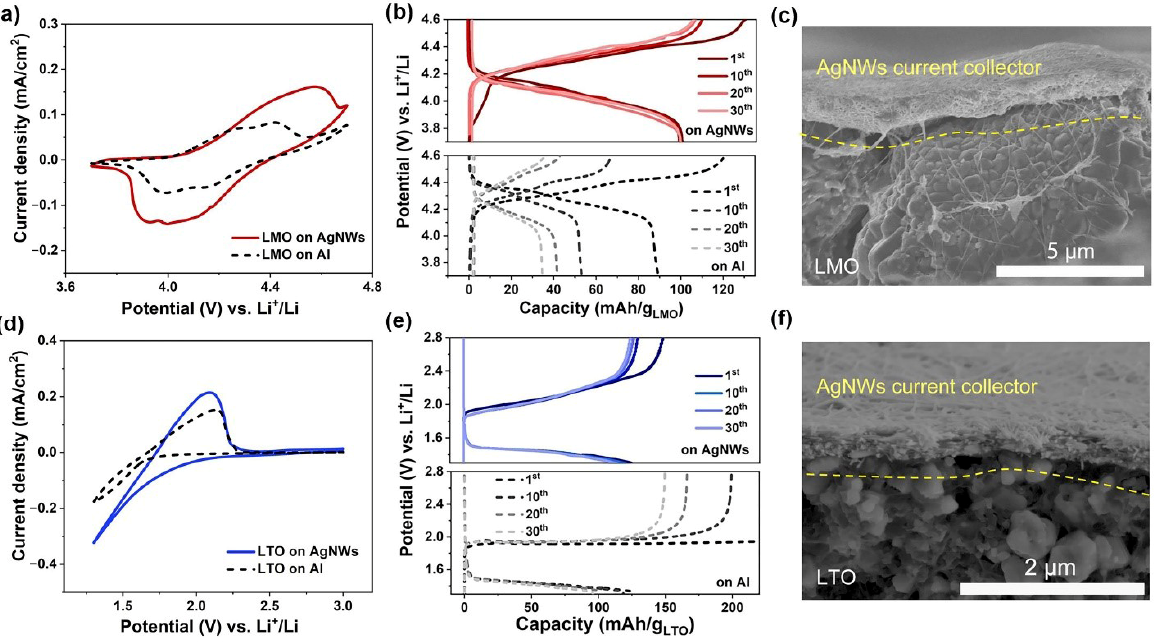
Figure 3. Cyclic voltammetry (CV) curves of ( a ) LMO and ( d ) LTO on AgNWs and Al foil current collectors in 2 m LiTFSI–94% PEG–6% H 2 O at 0.1 mV/s. Galvanostatic charge–discharge (GCD) curves of ( b ) LMO and ( e ) LTO on AgNWs and Al foil current collectors under the current densities of 14.8 mA/g and 17.5 mA/g, respectively. Cross-sectional SEM images of ( c ) LMO on AgNWs and ( f ) LTO on AgNWs.